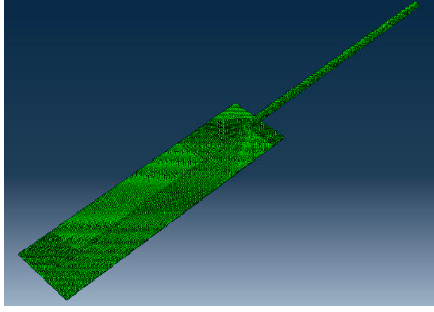
Figure 7. Finite element model of joint.